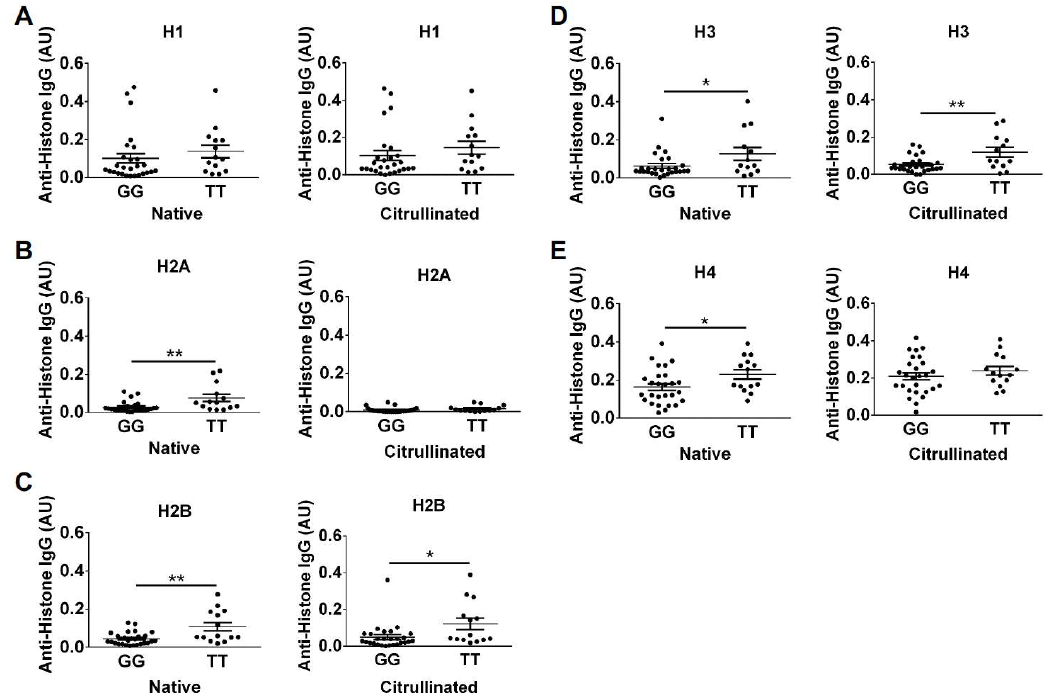
Figure 6. Reduced anti-histone IgG levels in CCP − rheumatoid arthritis subjects homozygous for the G allele at rs2240335. IgG levels against native and citrullinated histone H1 ( A ), histone H2A ( B ), histone H2B ( C ), histone H3 ( D ), and histone H4 ( E ), measured by ELISA in CCP − rheumatoid arthritis subjects homozygous for the G or T allele at rs2240335 were compared by t-test. For all panels, graphs depict average absorbance values in arbitrary units (AU) ± SEM; * p < 0.05, ** p < 0.01; n = 27 GG and n = 14 TT.